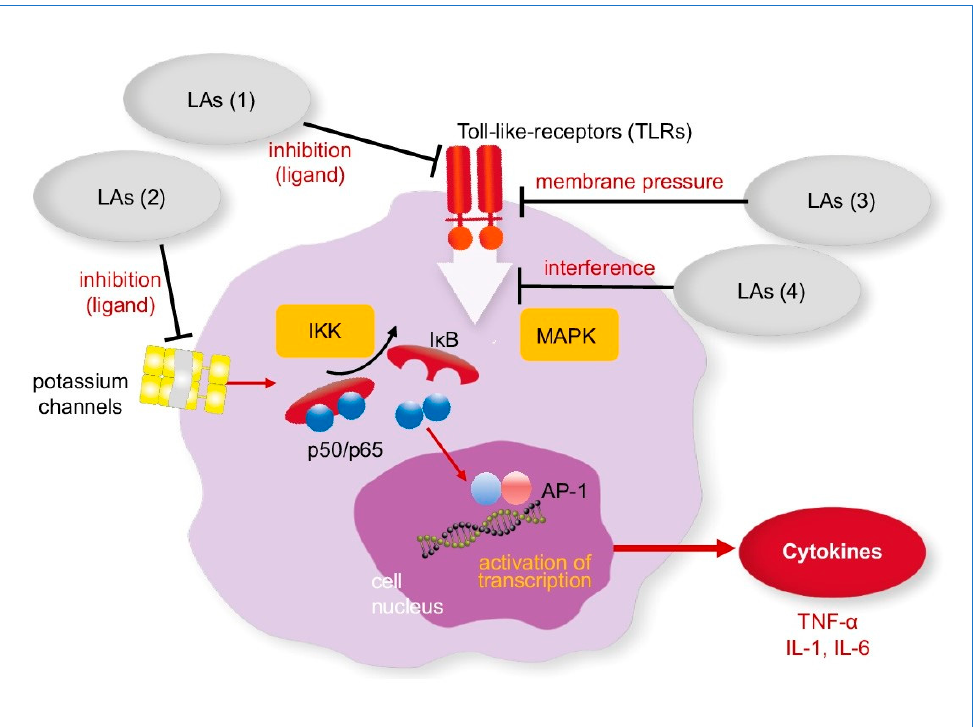
Figure 1. NF- κ B pathway: Potential interaction with local anesthetics. LA may inhibit membrane proteins; as TLRs (1) and potassium channels (2), may change the conformation and function of membrane proteins as TLRs by increasing the lateral membrane pressure (3) or may interfere with the NF- κ B pathway within the cell (4). I κ B: inhibitor of nuclear factor kappa B; IKK: IkB α kinase; IL-1, IL-6: Interleukin-1 and -6, as downstream products of TNF- α , LAs: Local anesthetics; MAPK: mitogen activated protein kinase; TLRs: Toll-like receptors.